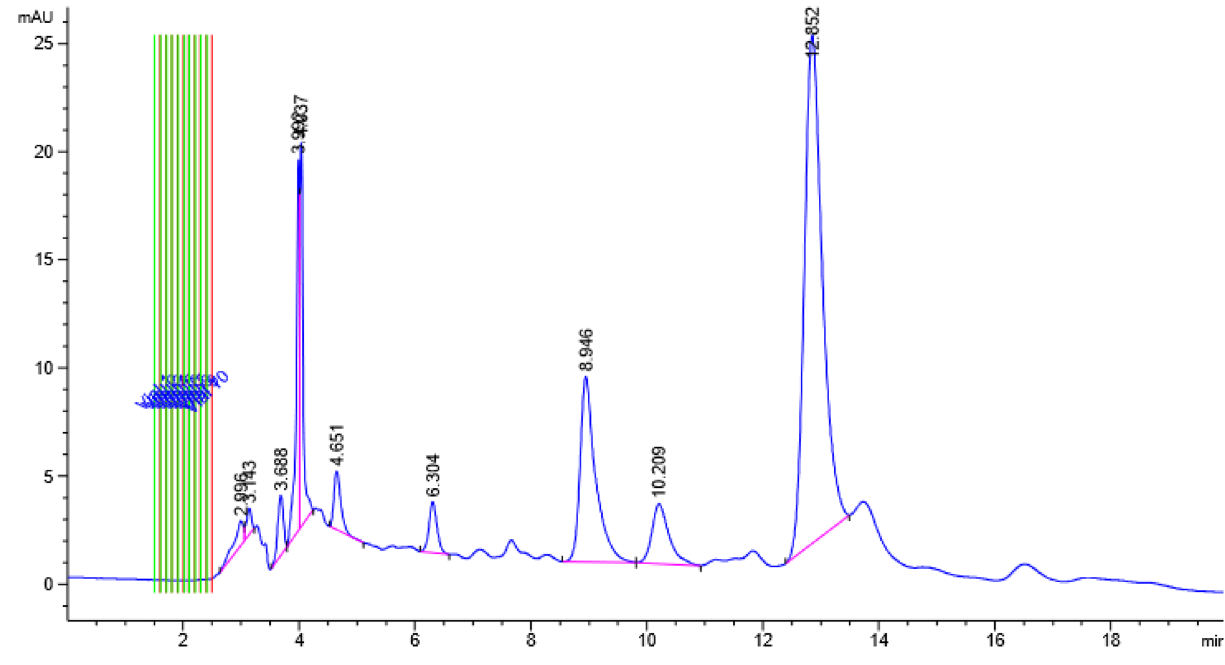
Figure 1. HPLC chromatogram of TA